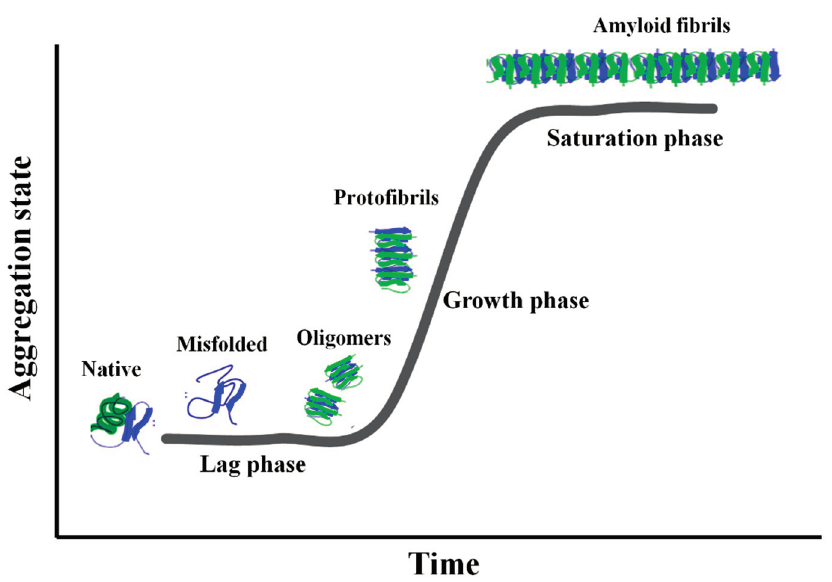
Figure 1. Nucleation-dependent fibril formation process The sequence of events along the fibril formation pathway includes: (Lag phase) aggregation of misfolded monomers into small intermediate oligomers; (Growth phase) re-arrangement of these oligomers into an organized conformation containing the cross beta structure; (Saturation phase) association of beta structured oligomers into proto-fibrils and finally into